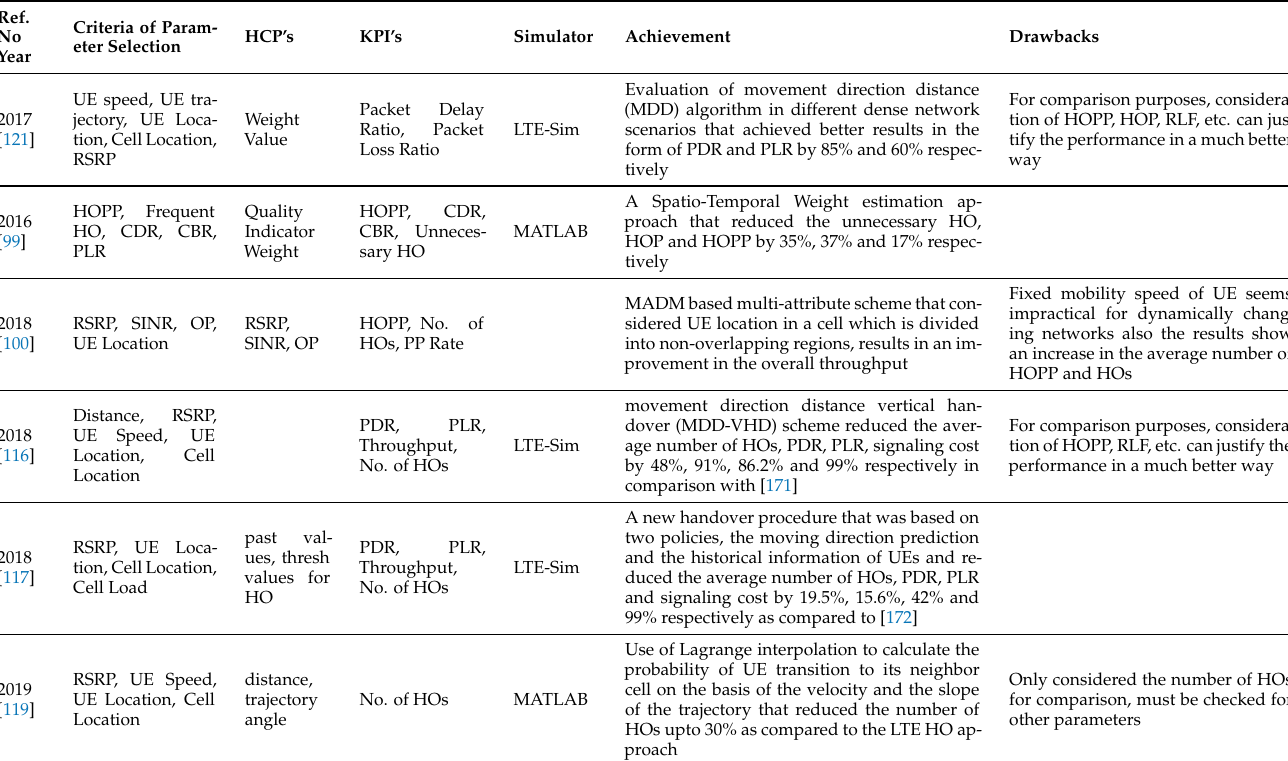
Table 10. Spatial Information based Handover Decision